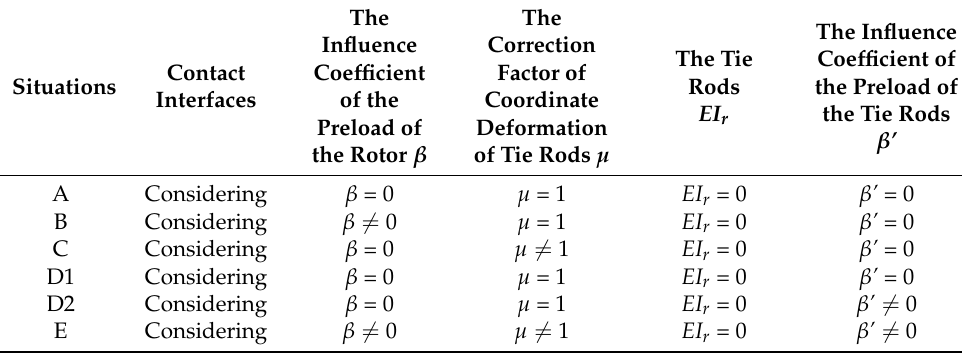
Table 1. The different situations.